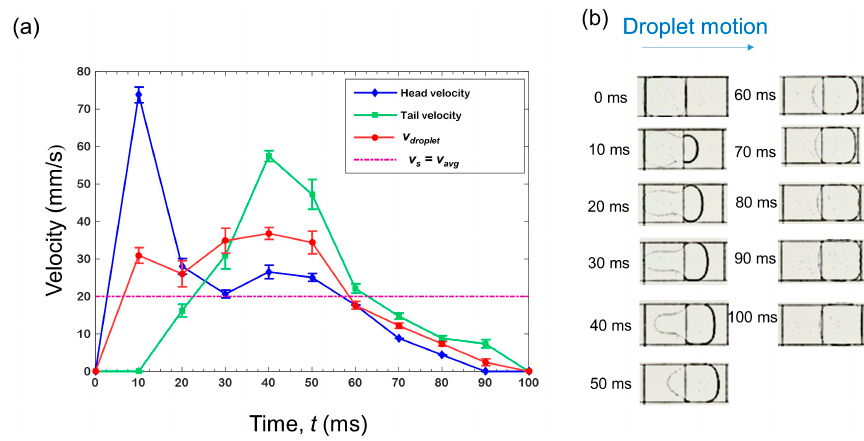
Figure 4. ( a ) Droplet velocity ( v droplet ) profile on a square electrode during one switching period. Velocities were calculated from three tests. Error bars reresent the standard deviation from the mean. Average velocity ( v avg ) and switching speed ( v s ) are equal and depicetd in purple dashed line. ( b ) Images of droplet shapes at different instants during t min (=100 ms) on a square electrode.